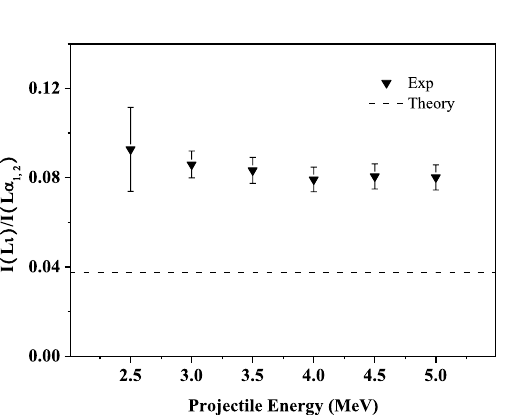
Figure 5. Relative intensity ratios of I Lι to Lα 1, 2 X-ray as a function of incident